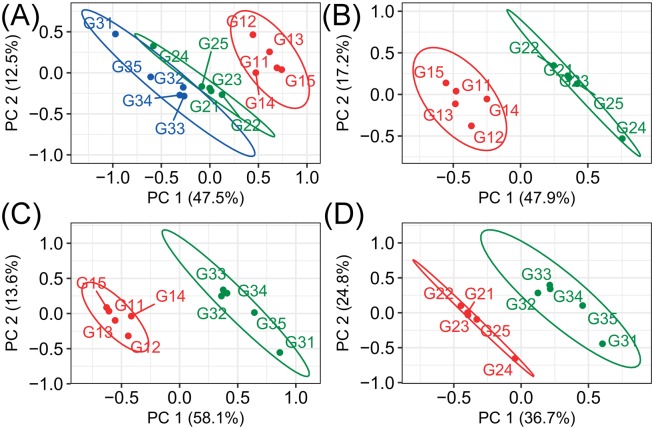
Score plots derived from principal component analysis (PCA) and partial least squares discriminant analysis (PLS-DA).(A): Score plots based on the first two components (PC1 vs PC2) derived from the PCA results. (B), (C) and (D): Score plots based on the first two latent components derived from the corresponding PLS-DA model for the three comparisons (G2 vs G1, G3 vs G1 and G3 vs G2). According to the paired comparison, the separation between every two groups was clear. The R2X, R2Y, Q2Y and RMSEE values in the PLS-DA models for groups G2 and G1 were 65.1%, 97.6%, 93.9% and 0.022, respectively. The R2X, R2Y, Q2Y and RMSEE values in the PLS-DA models for groups G3 and G1 were 71.7%, 98.9%, 97.1% and 0.012, respectively. The R2X, R2Y, Q2Y and RMSEE values in the PLS-DA models for groups G3 and G2 were 61.5%, 98.1%, 87.8% and 0.02, respectively. The ellipse for each group represented Hotelling’s T2 95% confidence interval.